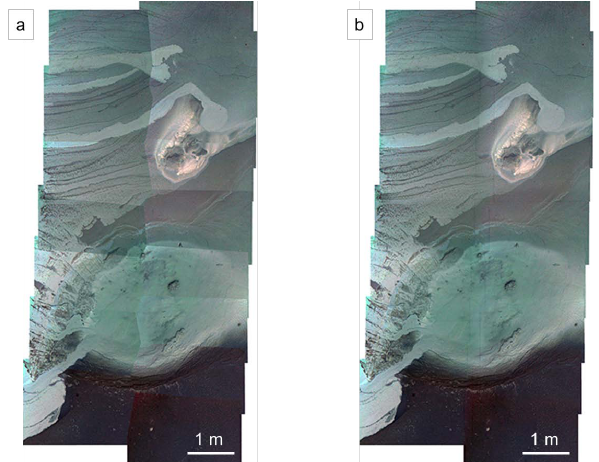
Fig. 8. Illustration of the two rendering options of the LAPM tool. (a) Clipping method: clear seams mark the transition between im- ages. (b) Blending method: seams are barely visible but computing times are longer. The photo-mosaics represent mud pools and mud flows at the Helgoland mud volcano (Black Sea).